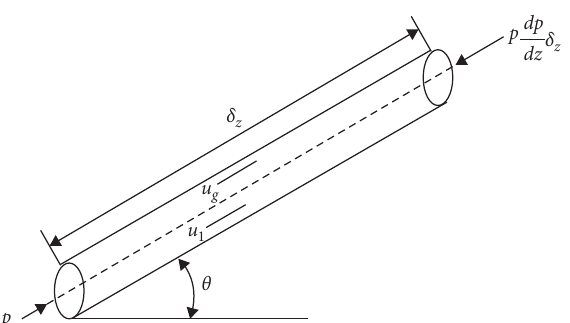
Figure 2: The control volume of the momentum equation of the two-phase and separated-flow